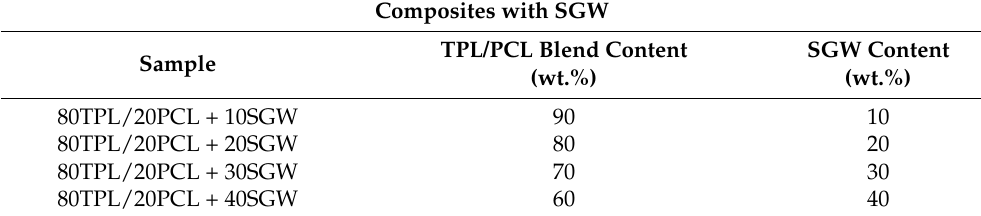
Table 1. Cont. Sample